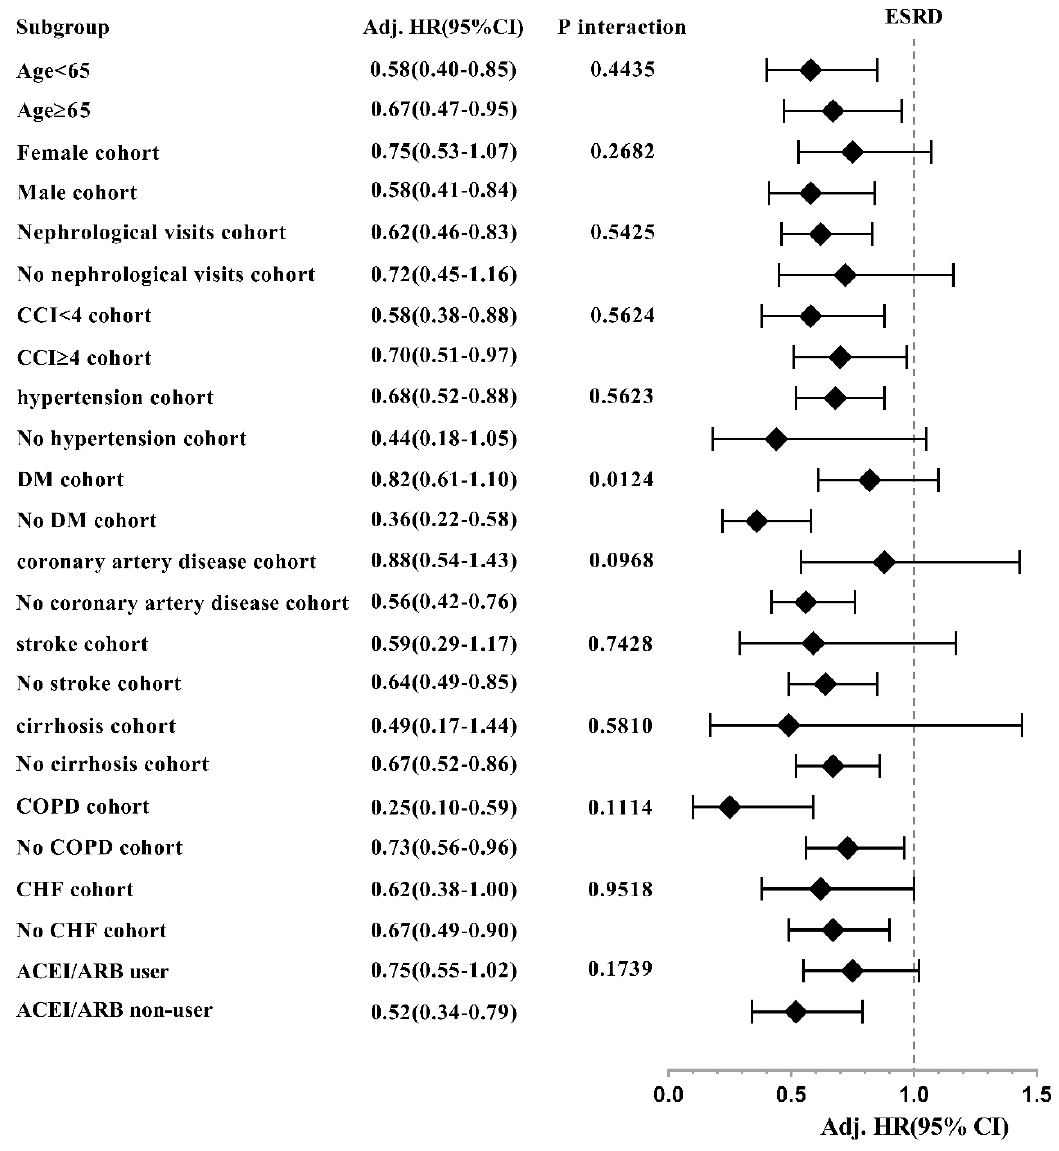
Figure 6. Hazard ratios of end-stage renal disease associated with spironolactone use in subgroup analyses.